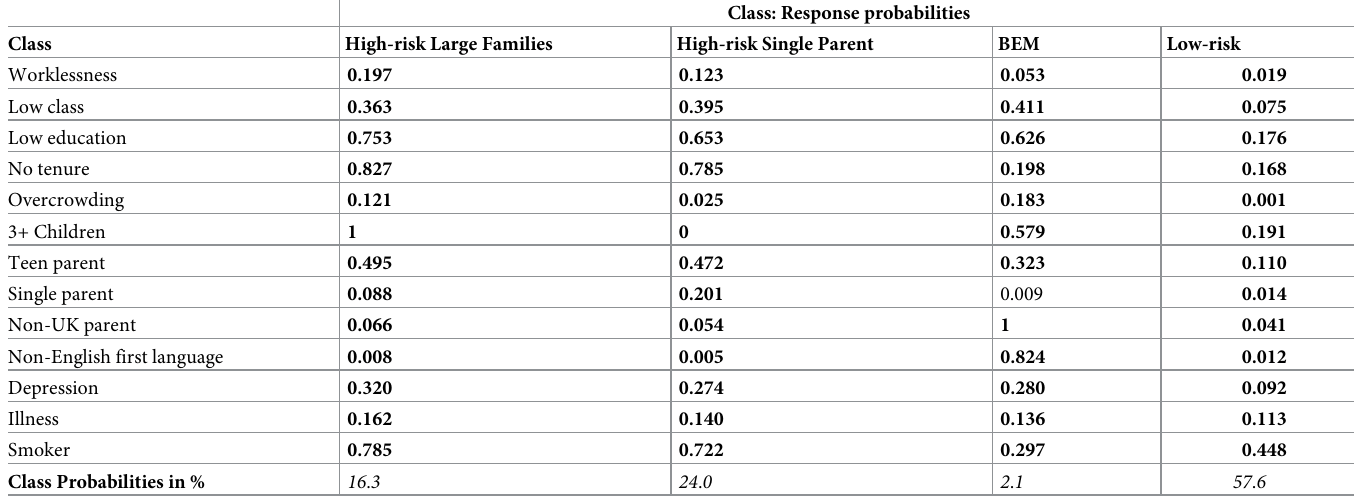
Table 3. Conditional response probabilities by latent class for G1.